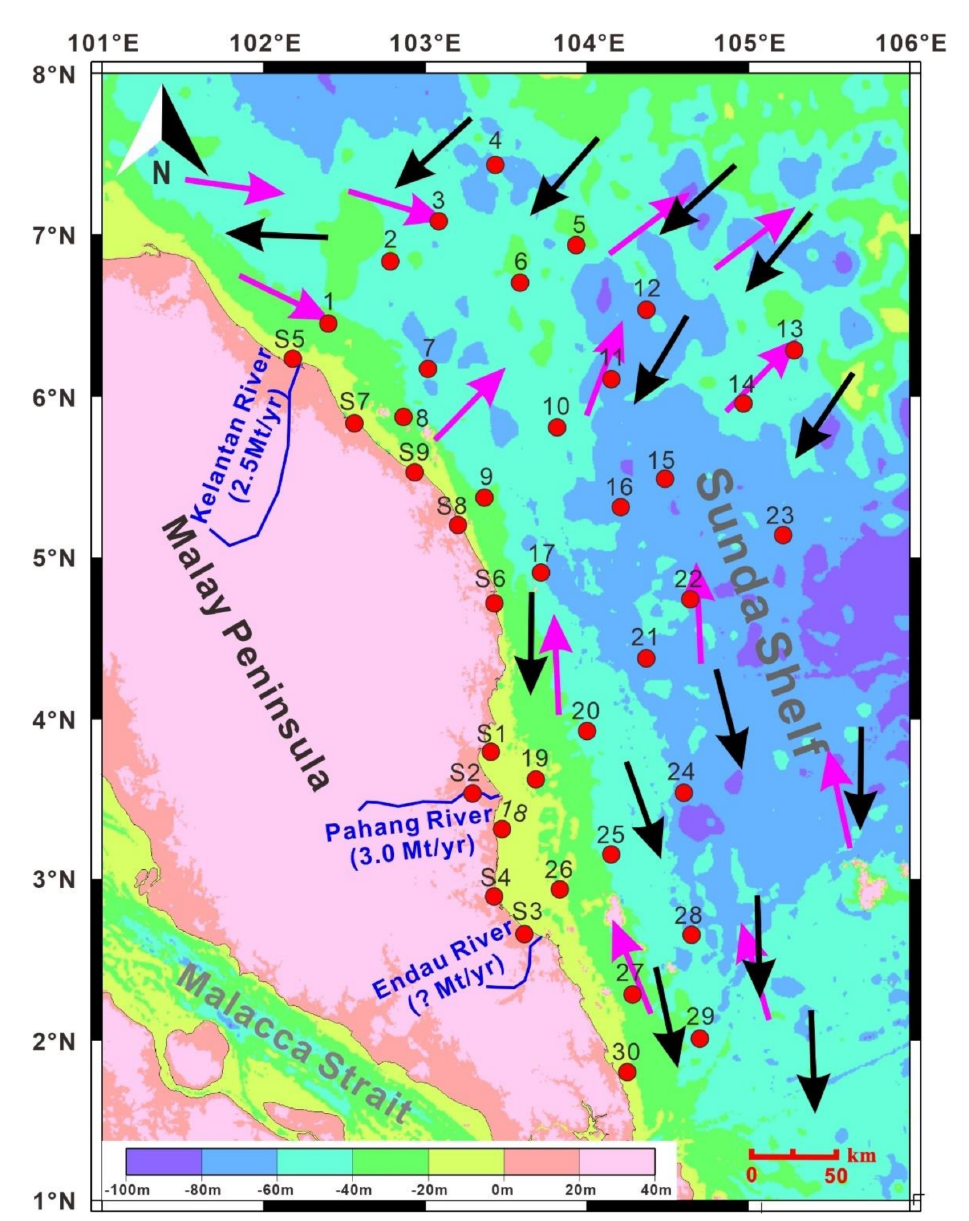
Figure 1. Distribution of surface sediment samples (red dots with numbers) collected from east- ern Malaysia and the neighbouring Sunda Shelf in the southern South China Sea. The values in blue bracket refer to sediment loads of rivers, and sediment loads of the Kelantan and Pahang rivers are from [2]; sediment load of the Endau River was determined from the river drainage area and the assumption that the Endau River sediment load is similar to that of the neighbouring Pahang River. Surface circulation during the winter (black arrows) and summer (pink arrows) was modified from